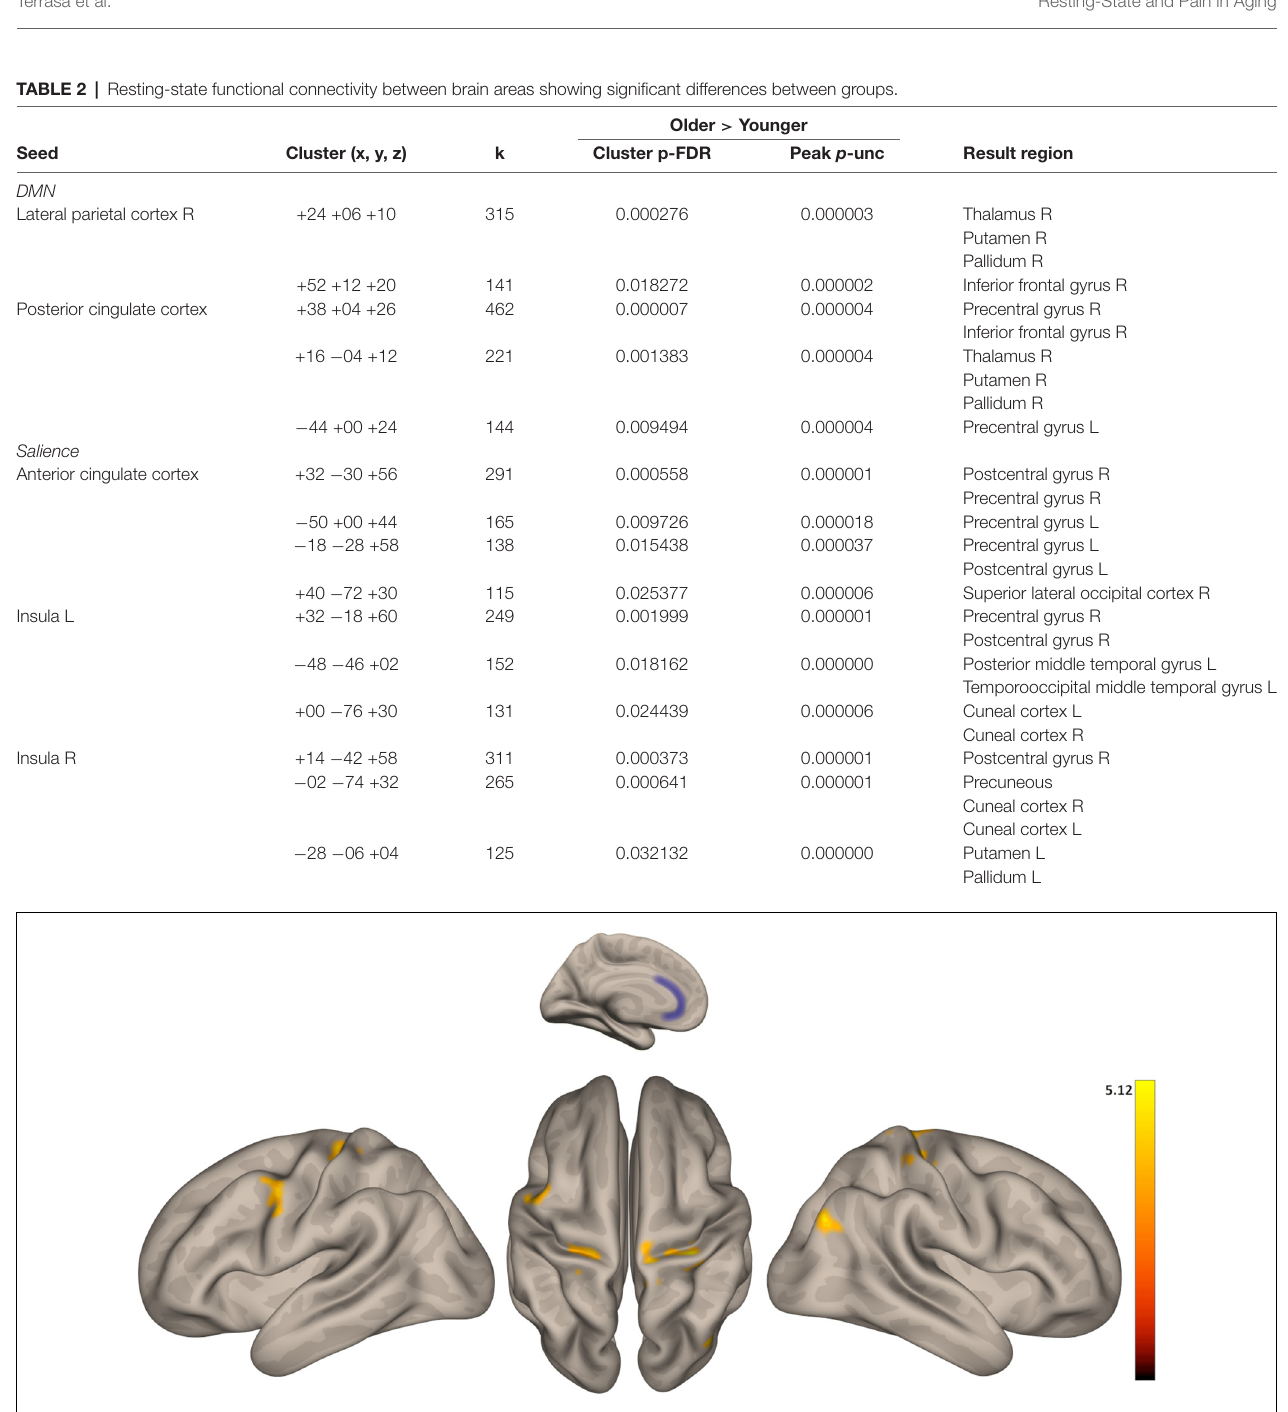
FIGURE 2 | Group differences in functional connectivity between the anterior cingulate cortex (ACC) with precentral and postcentral gyrus. Color indicates the greater connectivity in older participants when compared with younger